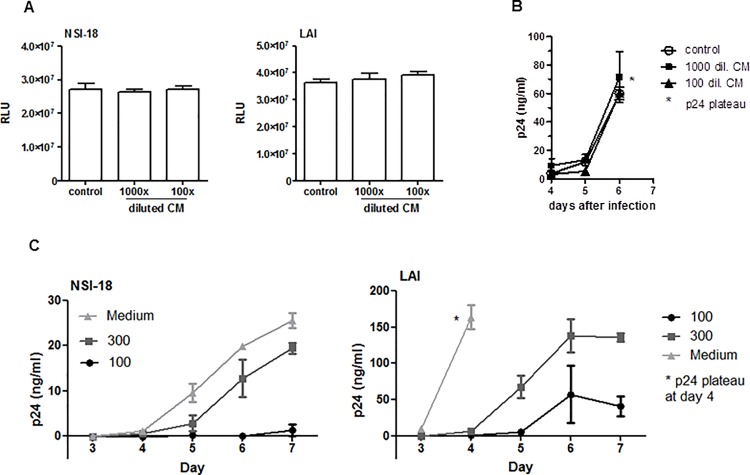
CM does not inhibit HIV-1 direct infection but does trans-infection.(A) NSI-18 (R5) or LAI (X4) (5ng/ml p24) was pre-incubated with medium (control) or 100 fold and 1000 fold diluted CM after which the mixture was added to TZM-bl cells. Two days post infection the cells were lysed and the luciferase activity was measured demonstrating that the level of infection was similar whether CM was present or not. (B) CD4+ T-lymphocytes were incubated with medium (control) or 100 fold and 1000 fold diluted CM prior to addition of LAI. Viral outgrowth, supernatant p24, was measured over several days, with no difference observed. (C) Raji DC-SIGN cells were incubated with medium (negative control) or 100 fold diluted CM or 300 fold diluted CM prior to addition of either NSI-18 or LAI virus, washed and added to CD4+ T-lymphocytes. Viral outgrowth, determined by capsid p24 ELISA, is depicted in Raji DC-SIGN cell—CD4+ T lymphocyte co-cultures. For both NSI-18 and LAI inhibition is observed with 100 fold diluted CM and less with 300 fold diluted CM. Data points were performed in triplicate.